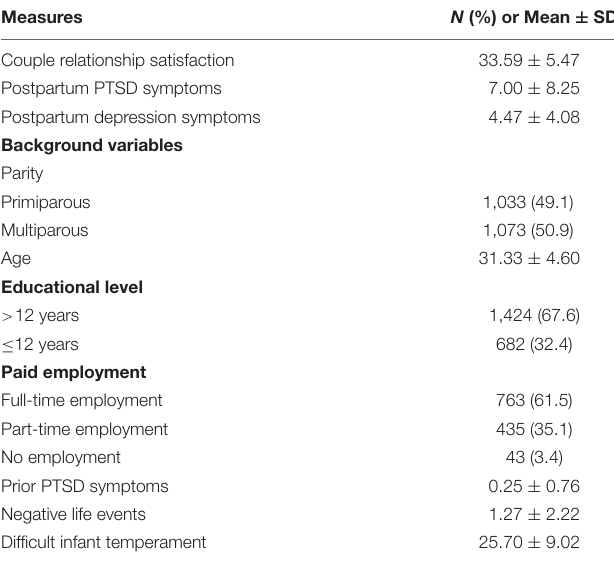
TABLE 1 | Means and SDs of all study